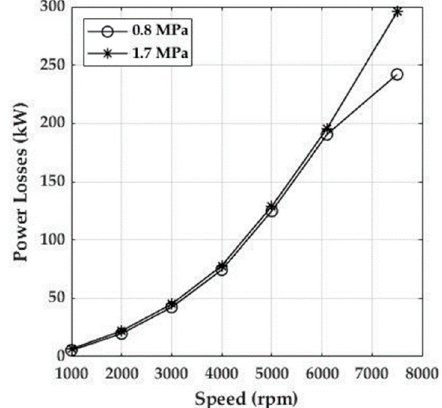
Figure 22. Direct Lube Rocker Pivot bearing pad power losses.